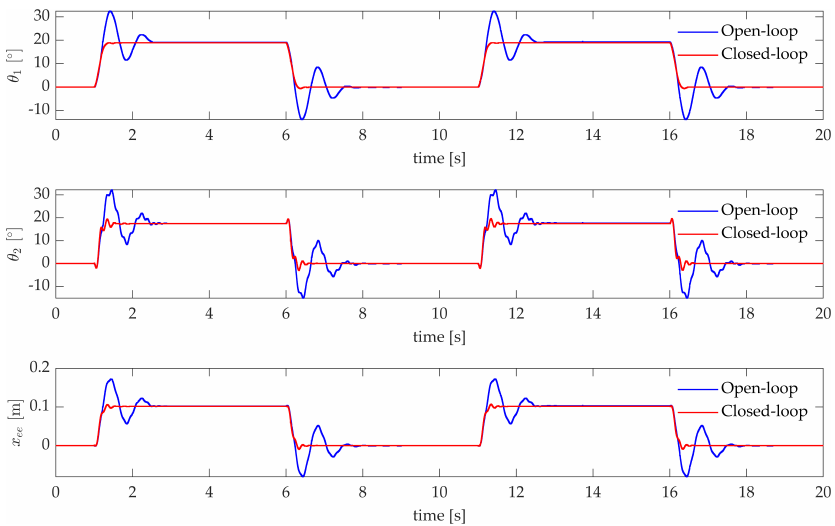
Figure 12. Test case 1: experimental pick-and-place